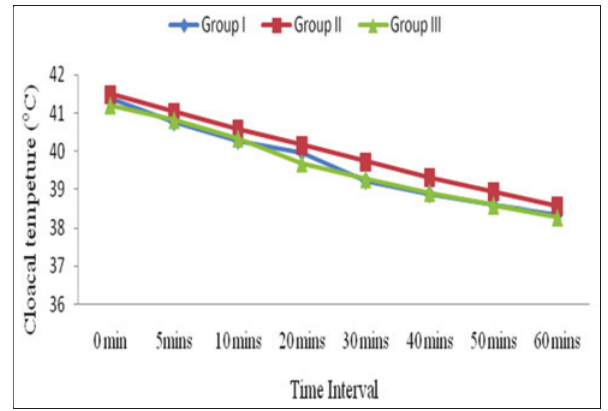
Figure-1: Mean cloacal temperature (°C) in birds of different groups.